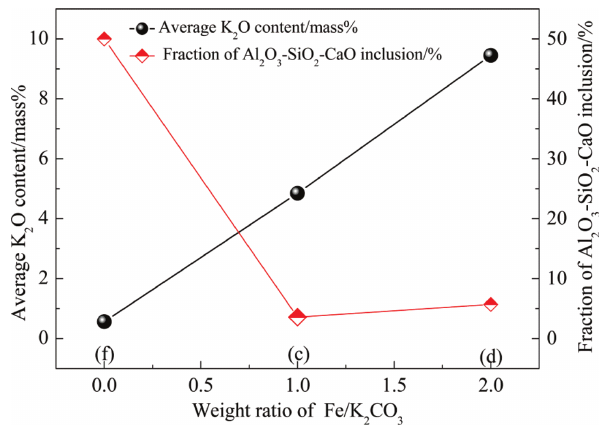
Figure 4: Average composition change of inclusions with reaction time in Heat g (without